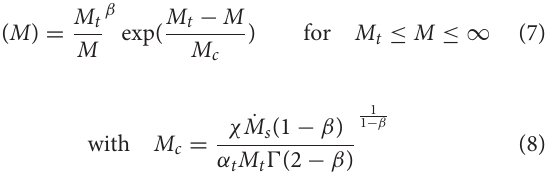
Total In-Range Mean Mean